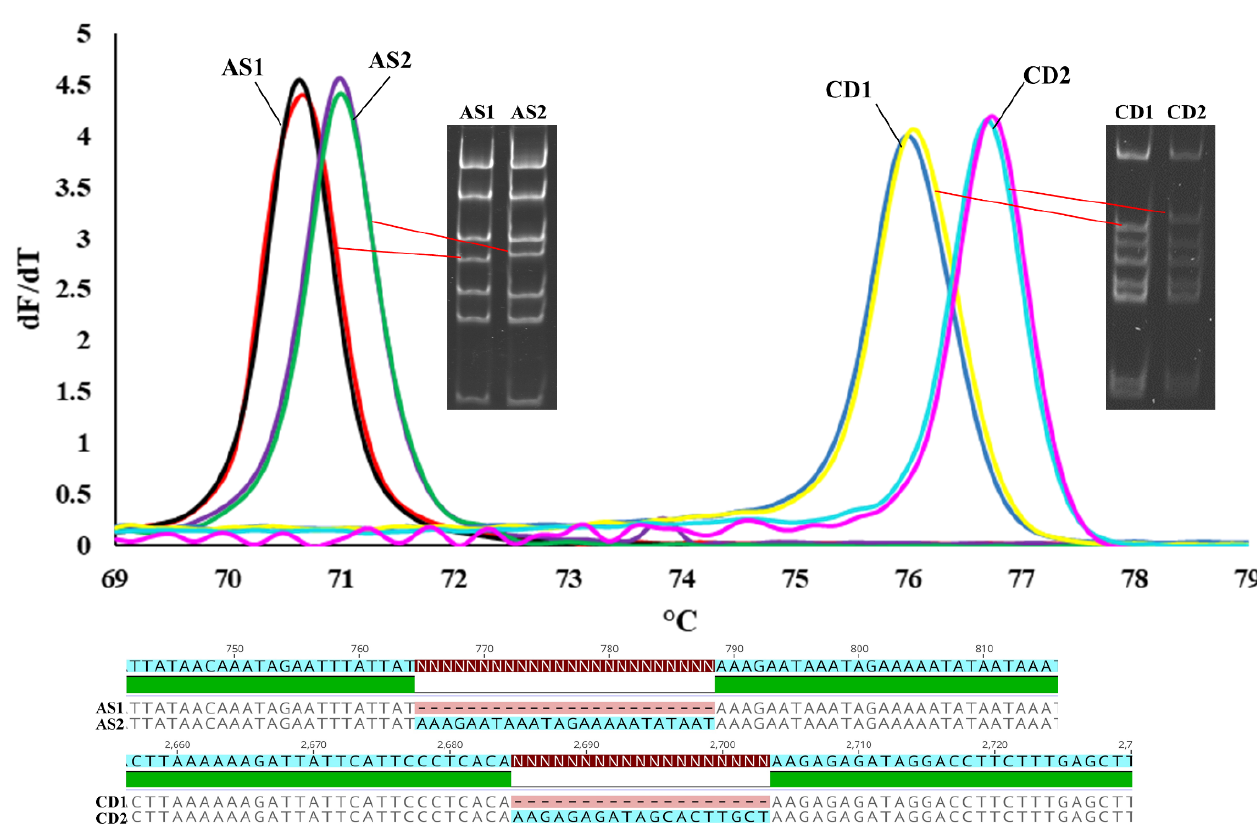
Figure 2. HRM profile of PCR-amplified regions of psa A- trn S (AS) and trn C-D (CD) which contain 24 bp and 19 bp indels, respectively ( n = 4). Indicated are the wet lab PCR RFLPs ( Taq I) which were used to identify the indels.